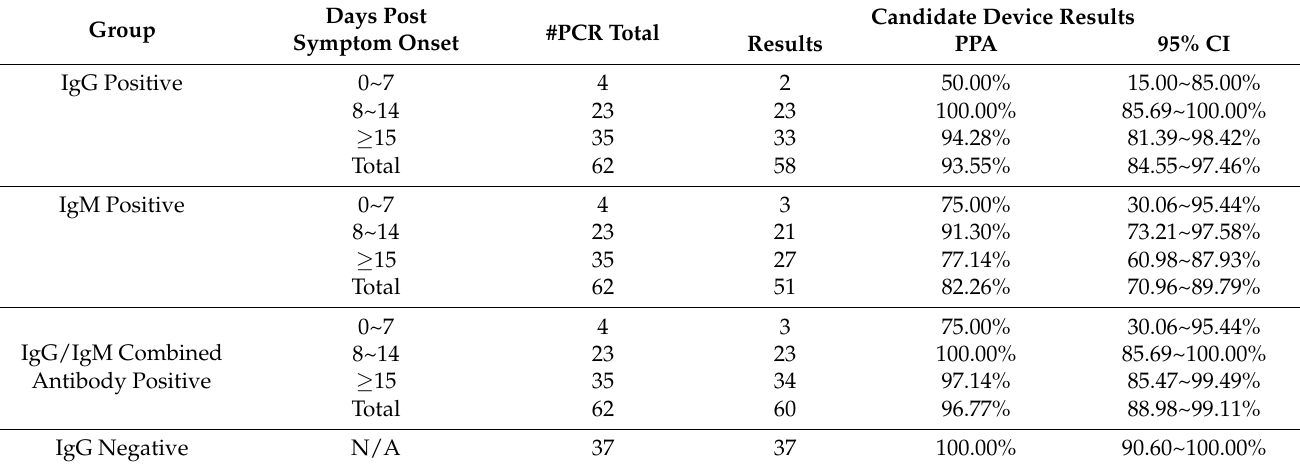
Table 4. Antibody percent agreement.